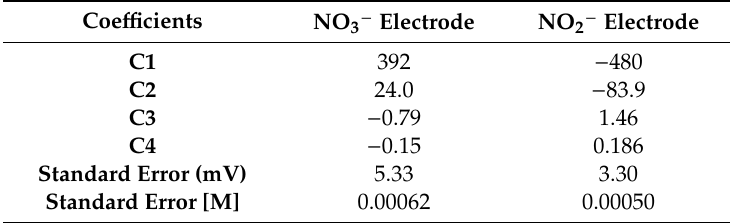
Table 6. Linear Regression Parameters and Terms for Nitrate and Nitrite